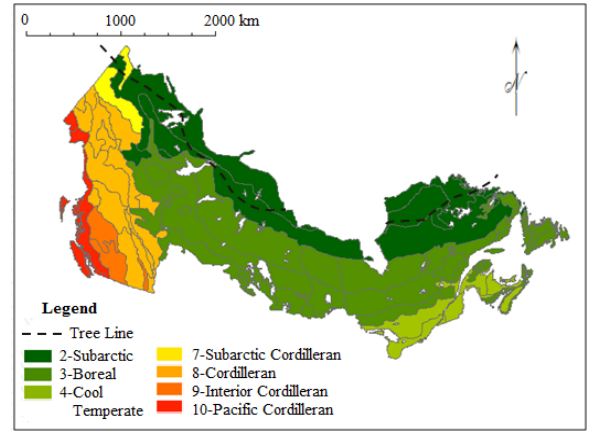
Figure 1. Study area of Canadian forest regions